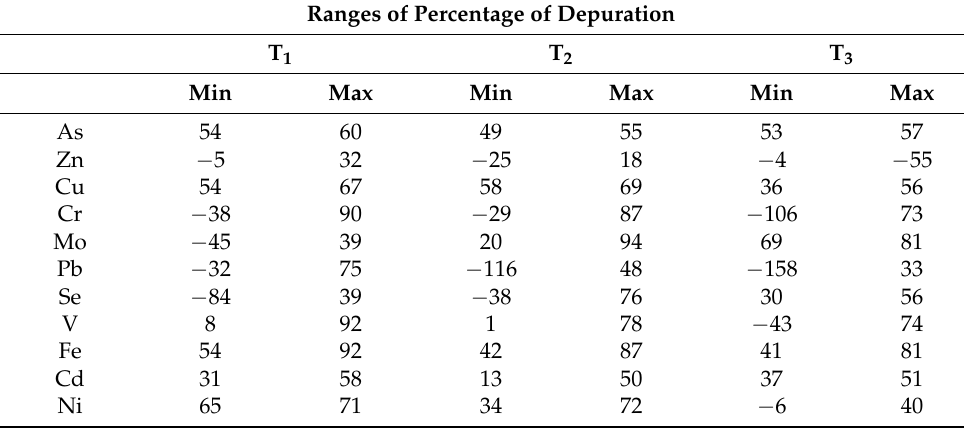
Table 1. Ranges of percentage of depuration (PD) of heavy metals in Gracilaria chilensis biomass under the proposed methodology. T 1 represents the values calculated after tap water submersion. T 2 and T 3 correspond to 14 and 21 days of culture after the first submersion, respectively. Positive values mean a decrease in the concentration, and negative values indicate a bioaccumulation of the heavy metals. For statistical results see Supplementary Material Table S1.